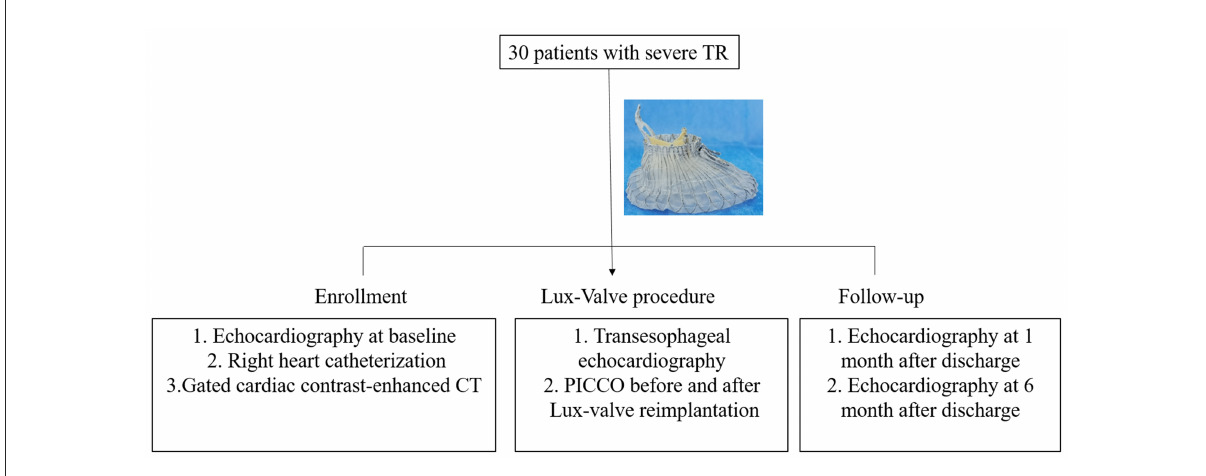
FIGURE1 The study design for hemodynamics management of